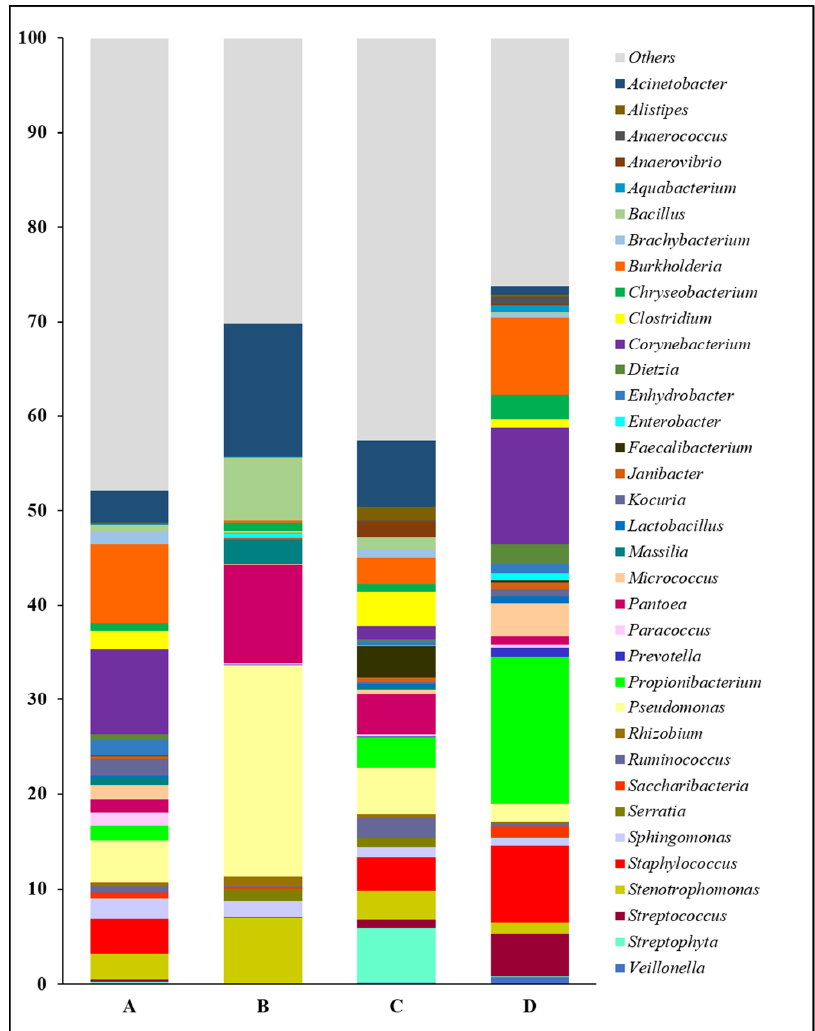
Figure 2. Relative abundance of forearm skin microflora at genus level. The relative skin microbial abundance of the top 35 genera in the investigated individuals from the dairy farm in Clarksville ( A ), the integrated farm in Upper Marlboro ( B ) and Washington DC ( C ), and University of Maryland—College Park campus ( D ) was analyzed and compared.